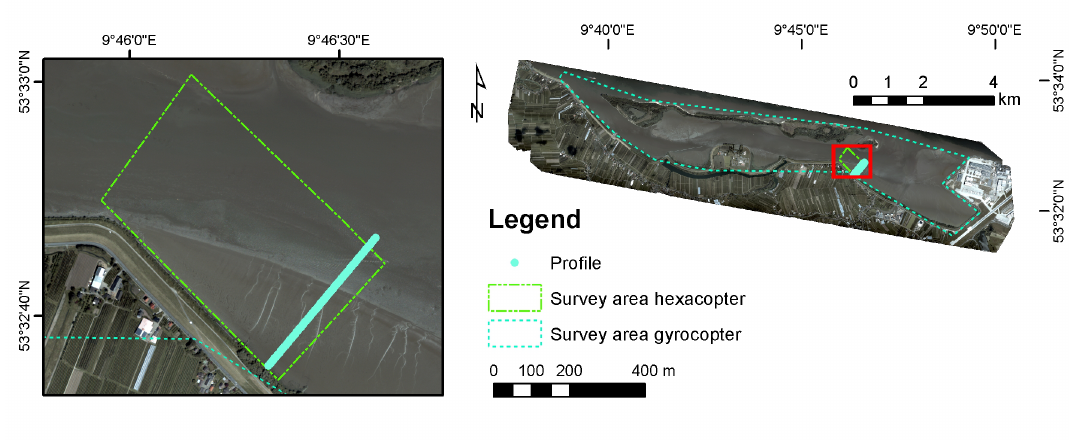
Figure 13. Location of the profile across the intertidal mudflats and the tidal channel within the hexacopter and gyrocopter survey area. The extent of the detailed map is marked by a red rectangle in the overview image on the